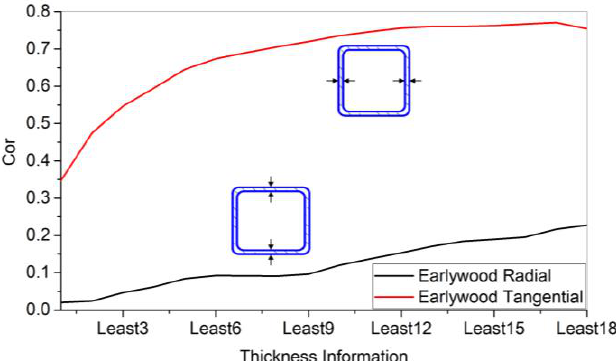
Figure 13. The correlation coefficient between yield force and the thickness data of cell walls in the radial and tangential direction of earlywood.